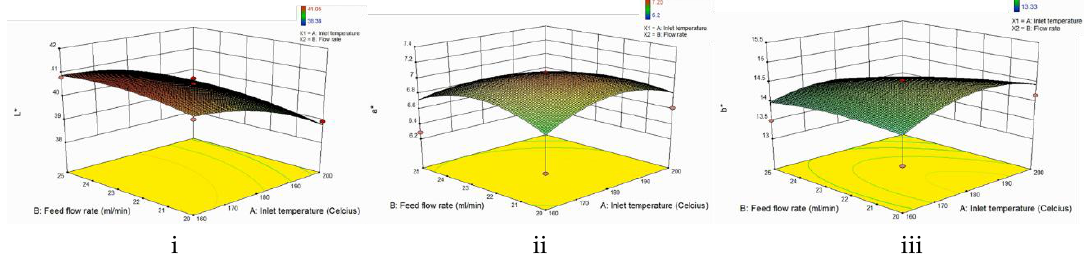
Figure 3. Three-dimensional surface plot of the effect of inlet temperature and feed flow rate to the color analysis of powder ( i ) L* value, ( ii ) a* value, ( iii ) b* value.